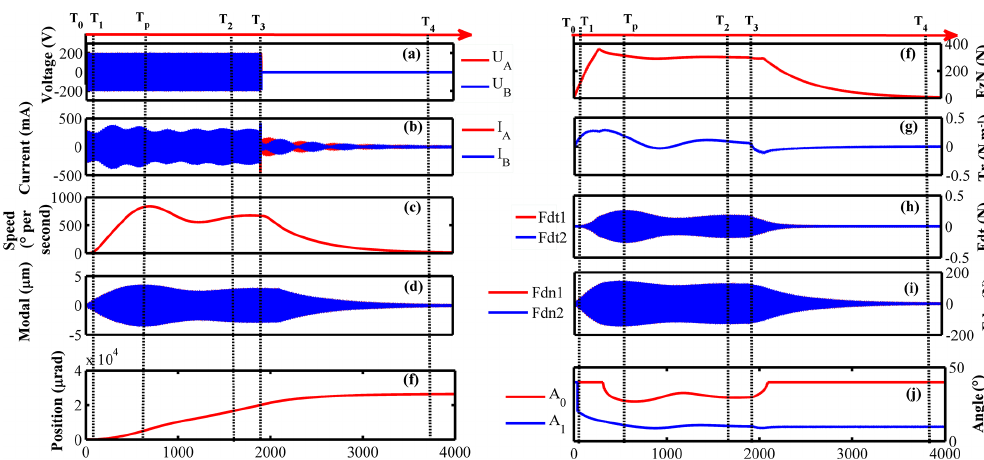
Figure 6. Transient response of the unloaded motor with the driving signals containing 800 periods of activation: (a) the two-phase input voltages, (b) the vertical force applied in the rotor, (c) two-phase input currents, (d) the output torque, (e) the two-phase vibration response, (f) the tangential modal forces, (g) the revolving speed, (h) the vertical modal forces, (i) the rotor angle, and (j) the contact parameters.